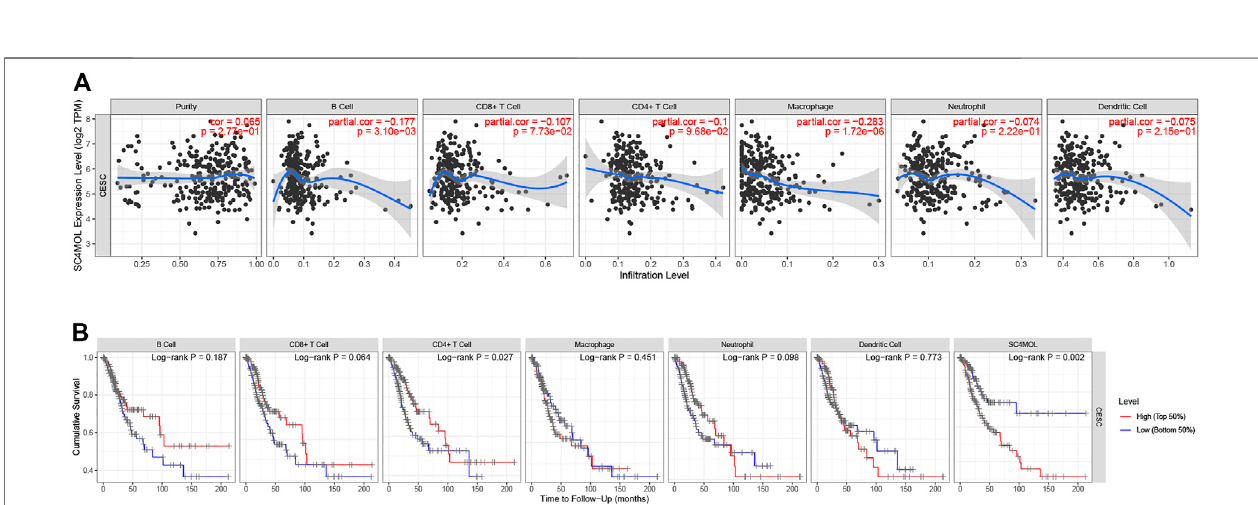
FIGURE14| ThecorrelationofMSMO1 expression with immune in fi ltration level and cumulative survival inCESC from TIMER. (A) Theexpression level ofMSMO1 issigni fi cantlynegativelycorrelated withthe in fi ltration level ofCD4 + Tcells, Macrophages, Neutrophilsand DCs. (There isanegativecorrelation betweenthe expression levels of MSMO1, the degree of invasion of CD4 + T cells (r (cid:1) − 0.1, p (cid:1) 9.68e-02), Macrophages (r (cid:1) − 0.283, p (cid:1) 1.72e-06), Neutrophils (r (cid:1) − 0.074, p (cid:1) 2.22e-01), and DCs(r (cid:1) − 0.075, p (cid:1) 2.15e-01)). (B) CumulativesurvivalisrelatedtoBcell,Tcells,Macrophages,Neutrophils,andDCsinCESC.(TheBcell,Tcells,Macrophages, Neutrophils, and DCs are factors related to the cumulative survival rate of CESC over time).